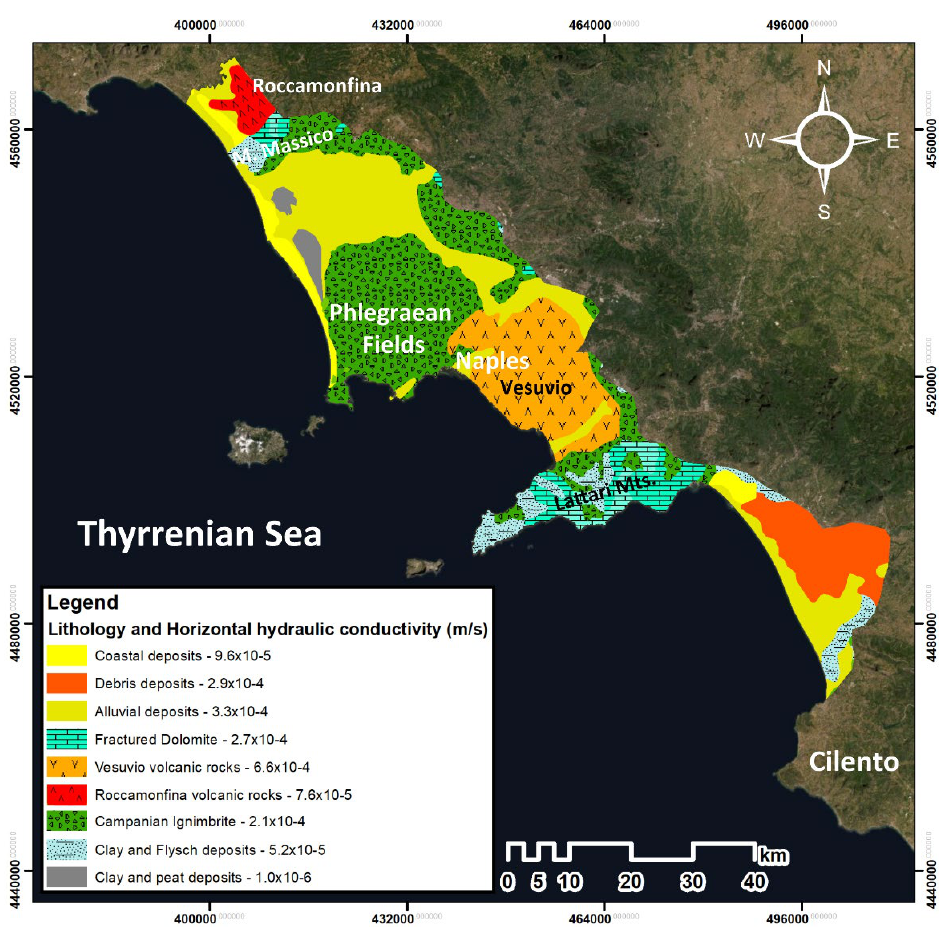
Figure 2. Distribution of the lithological units and their horizontal hydraulic conductivity values in layer 1 of the model domain.